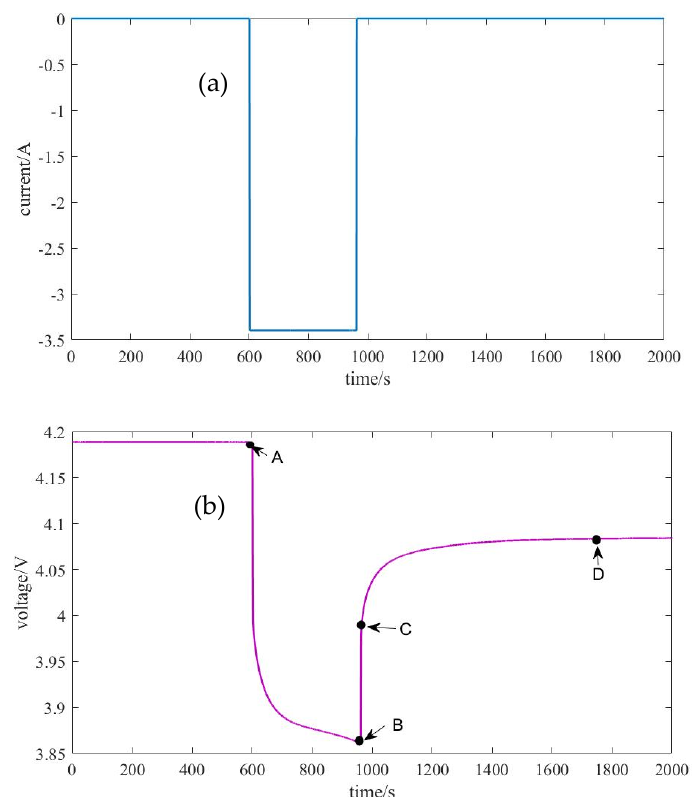
Figure 3. Single-stage discharge current and voltage curves: ( a ) the single-stage discharge current curve; ( b ) the single-stage discharge voltage curve. Notes: A and B are the starting and ending points of circuit in a discharge stage, respectively; C and D are the inflexion and end points of circuit in a quiescent